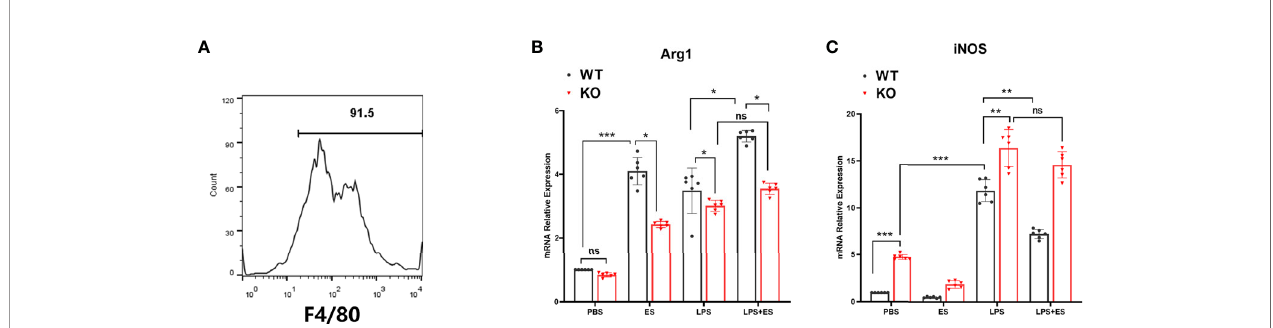
FIGURE 1 | Expression of iNOS and Arg1 in wild type (WT) or Nrf2 KO macrophages induced by T. spiralis ES. Macrophages were enriched by positive selection with anti- F4/80 magnetic beads. The enriched F4/80 + macrophages were typically of > 90% purity as determined by fl ow cytometry (A) . Total RNA was extracted from cells and mRNA expression levels of Arg1 (B) and iNOS (C) were quanti fi ed using RT-PCR. The results are presented as the mean ± SD of each group (n=6) *P < 0.05, **P < 0.01, ***P < 0.001, ns, no signi fi cance, as indicated by the line (one-way ANOVA with Tukey ’ s post